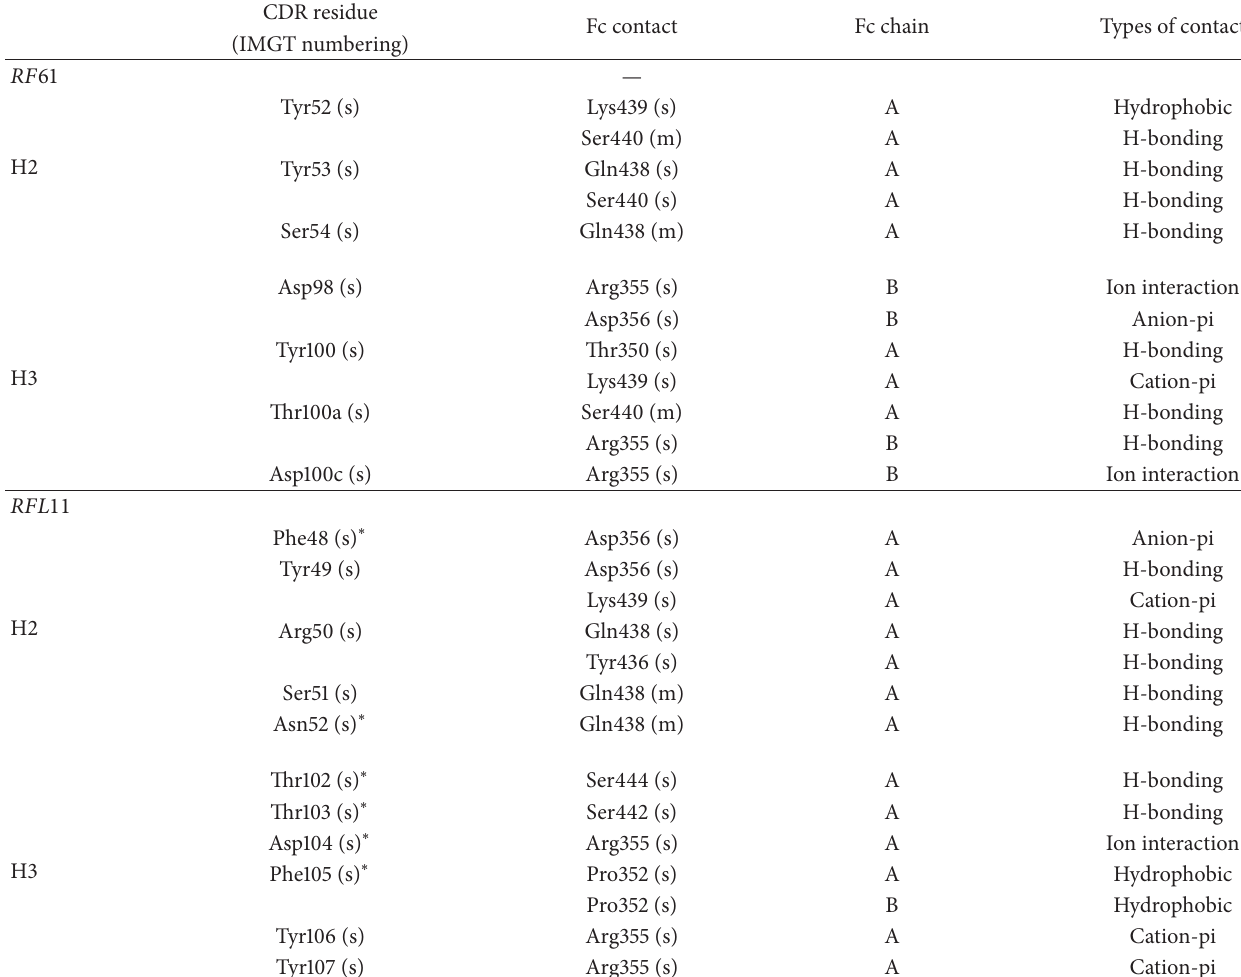
Table 1: Comparison of contact residues in RF61 and RFL11 interaction with